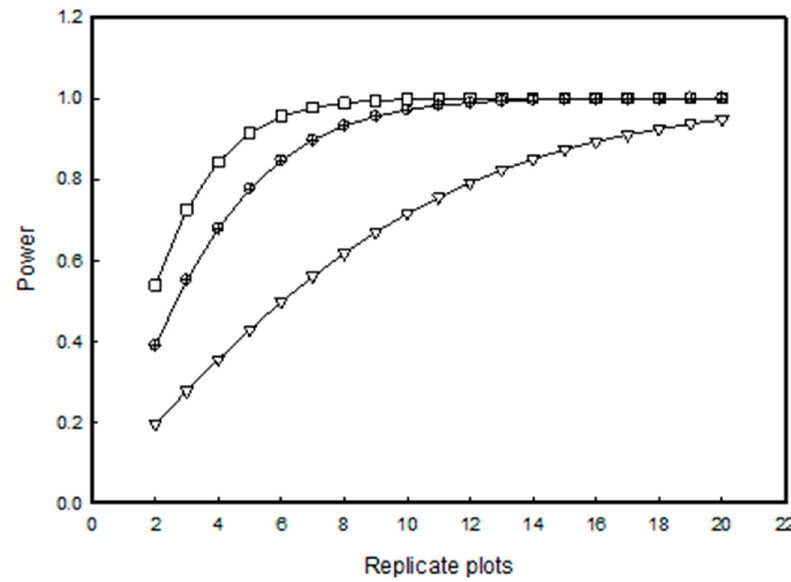
Figure 2. Effect of the number of replicate plots on the likelihood of detecting differences in metabolisable energy between candidates at Timboon (squares), Tongala (circles), Elliott (crosses) and Ellinbank (triangles).